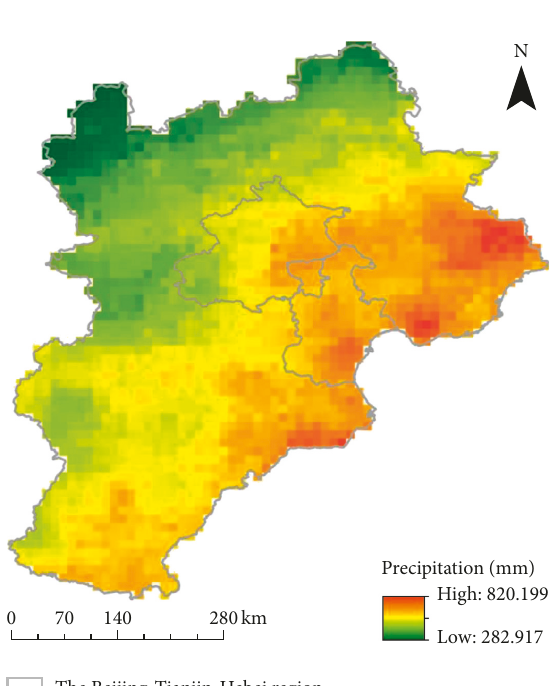
Figure 9: Mean annual precipitation based on modified GPM-M data (CDF